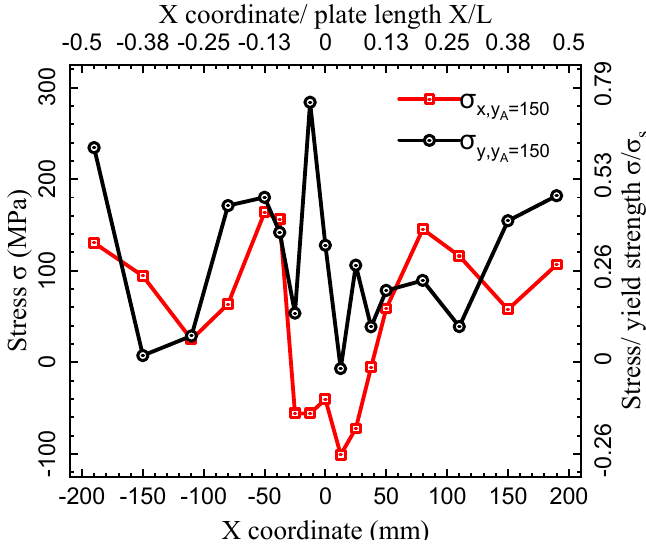
. . (cid:3250) (cid:2880)(cid:2869)(cid:2873)(cid:2868) (cid:3250) (cid:2880)(cid:2869)(cid:2873)(cid:2868)